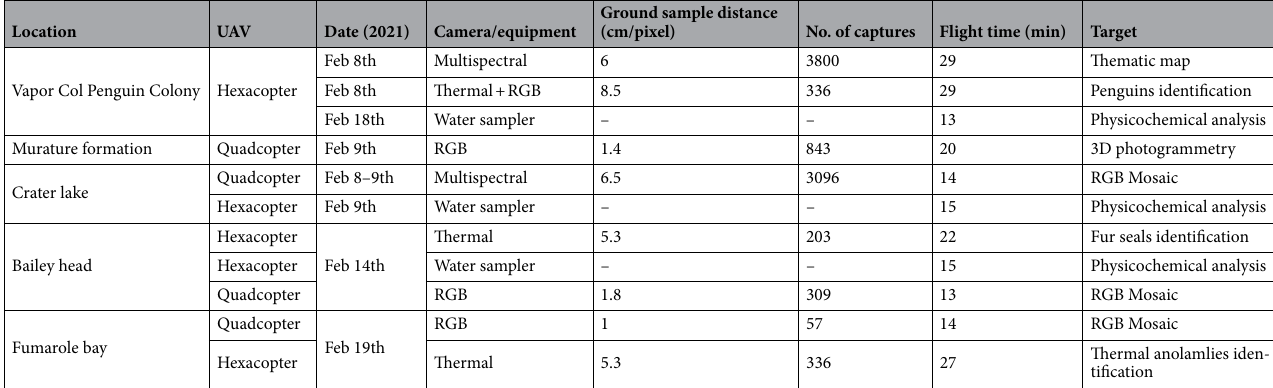
Table 1. Information and aims of UAV surveys carried out on Deception Island. Imaging overlap selected was 80% frontal and 70% side.